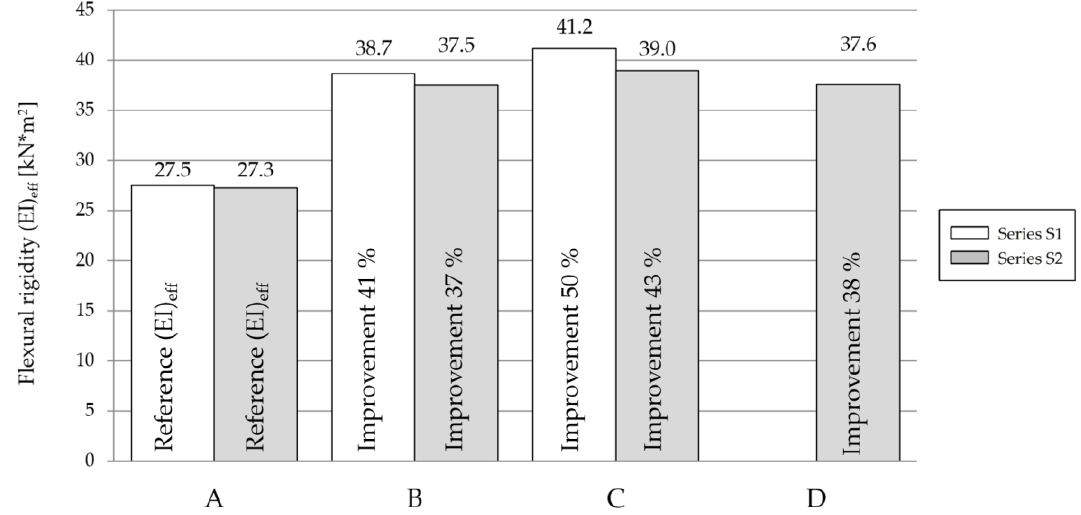
Figure 11. Effective flexural rigidity of type A, B, C, and D specimens.